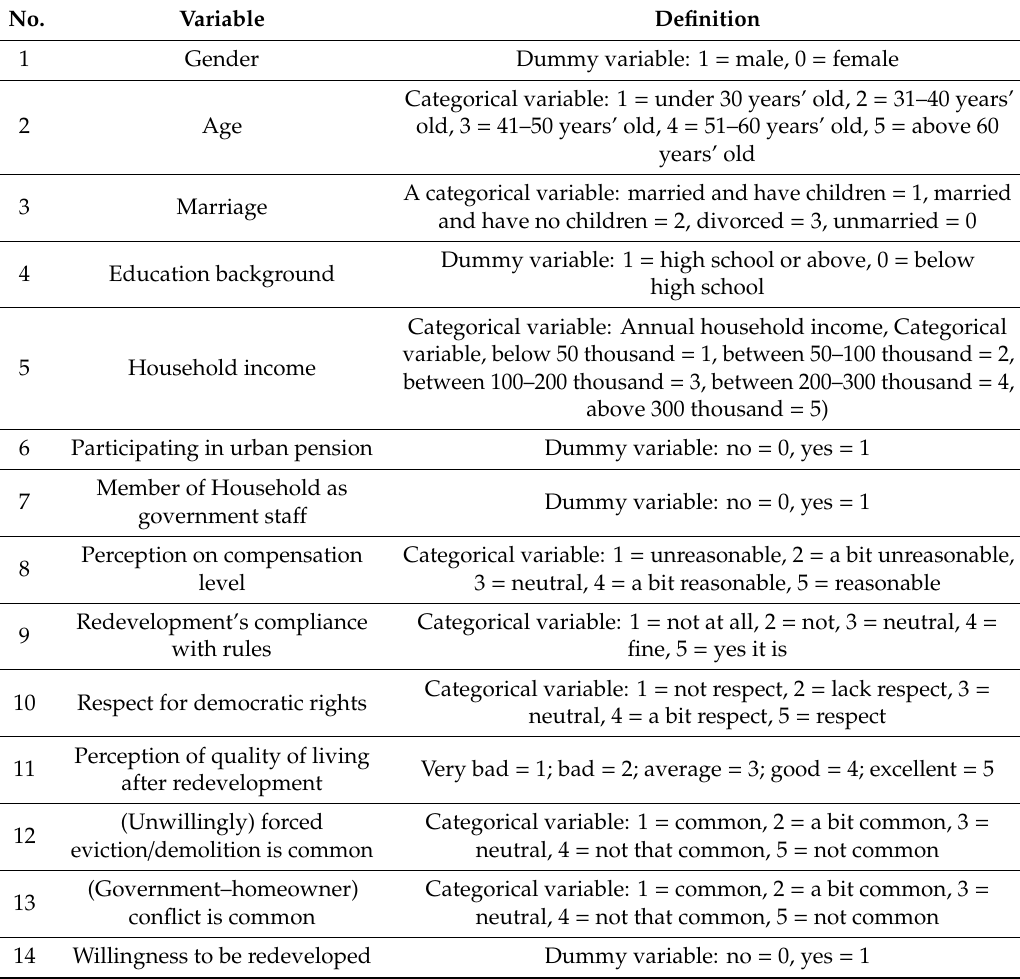
Table 3. Definitions of variables.